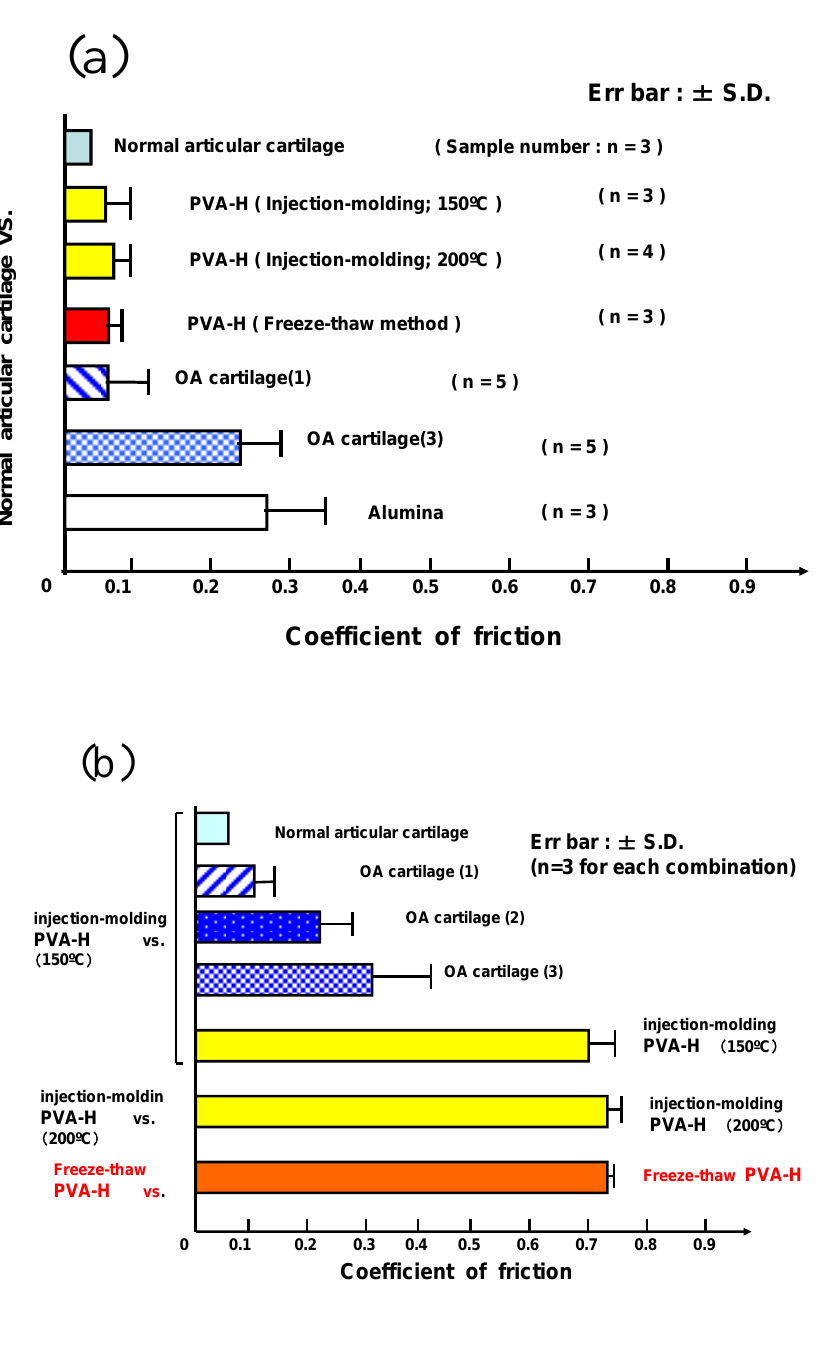
Figure 5. Coefficients of friction for various combinations of materials. Friction coefficients of various materials specimens against normal articular cartilage (a). against